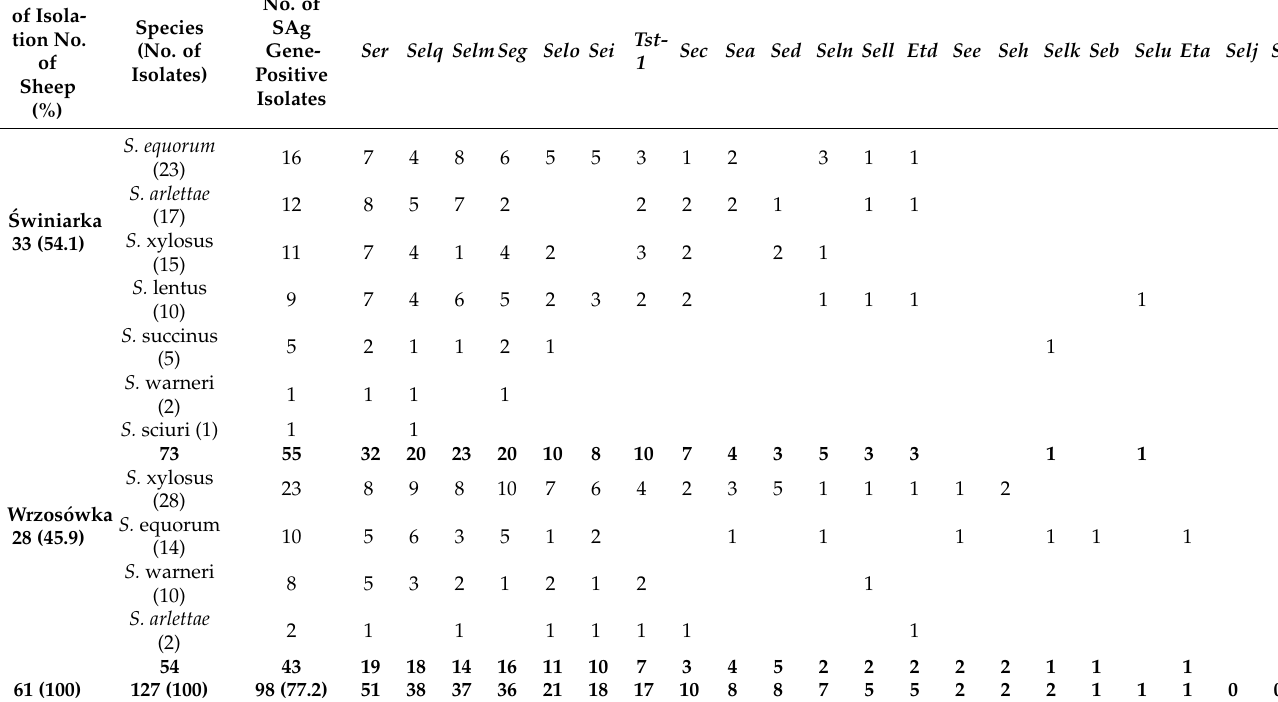
Table 4. Relationship between source of isolation and prevalence of superantigen (SAg) genes among Staphylococcus